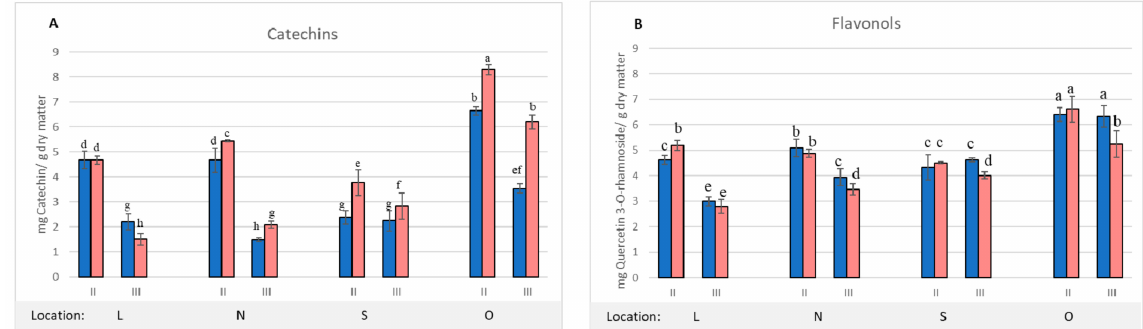
Figure 4. The sum of catechins ( A ) and the sum of flavonols ( B ) in uninfested (blue) and infested (pink) chestnut leaves on two harvest dates, calculated on the basis of HPLC analysis. The mean values denoted by different letters differ statistically significantly at p <